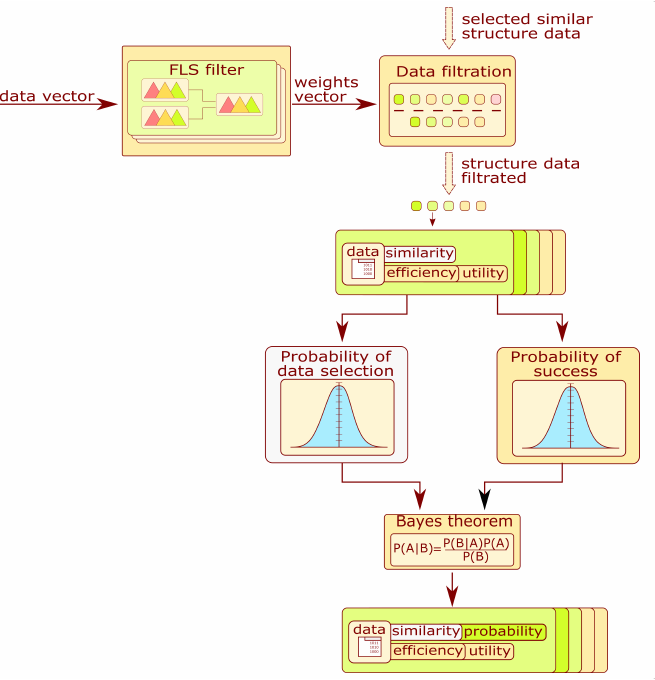
Figure 7. Block diagram of algorithm selector